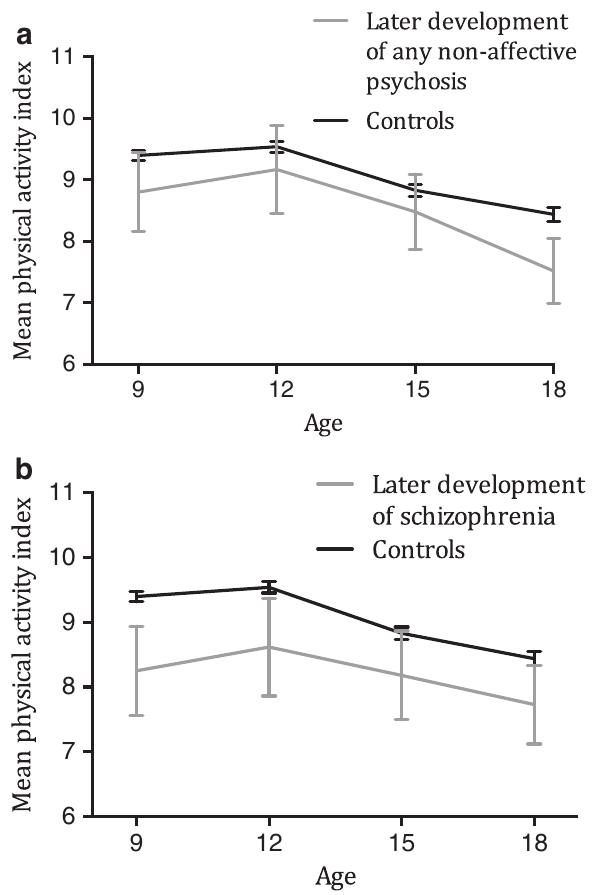
Fig. 1 Mean (95% CI) physical activity index (range 5 – 14) in children and adolescents at 9 – 18 years of age. Gray line = individuals who later developed any non-affective psychosis (a) schizophrenia (b) and black line = controls with no psychiatric diagnoses during the